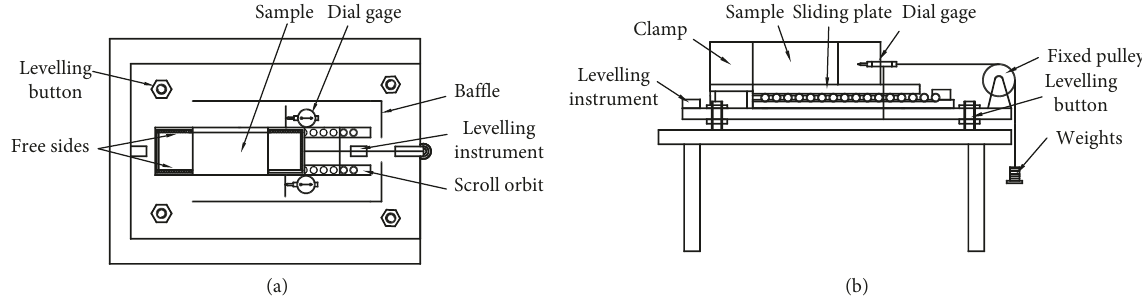
Figure 1: Schematic drawing of the tension apparatus: (a) vertical view; (b) side view.